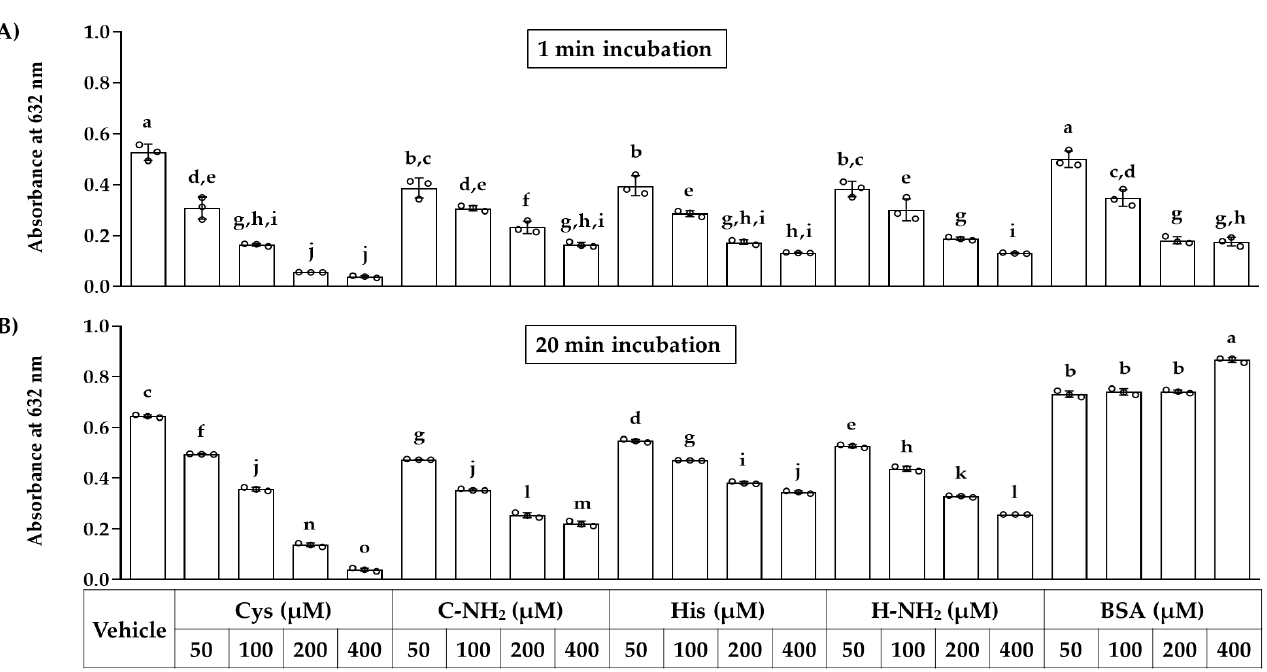
Figure 8. Comparison of copper-chelating activities of cysteine, cysteinamide, histidine, histidinamide, and bovine serum albumin (BSA). The reaction mixture consisting of 200 μM CuSO 4 , 200 μM PCV, and test material at the specified concentrations was incubated for 1 min ( A ) or 20 min ( B ), and the formation of Cu(II)-PCV complex was measured using A 632 . Data are presented as mean ± SD (n = 3). Different lowercase letters (a–o) indicate significantly different means at the p < 0.05 level.